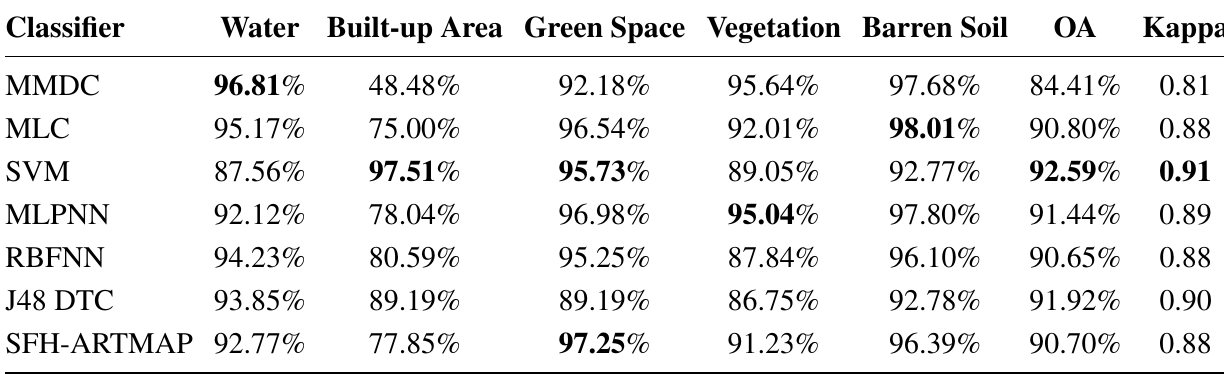
Table 2. Classification accuracy of the first Scheme (only spectral features).